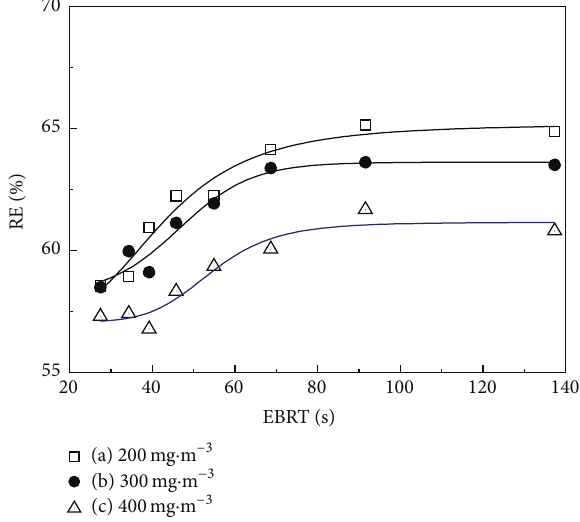
Figure 5: The effects of EBRT on ethanethiol removal